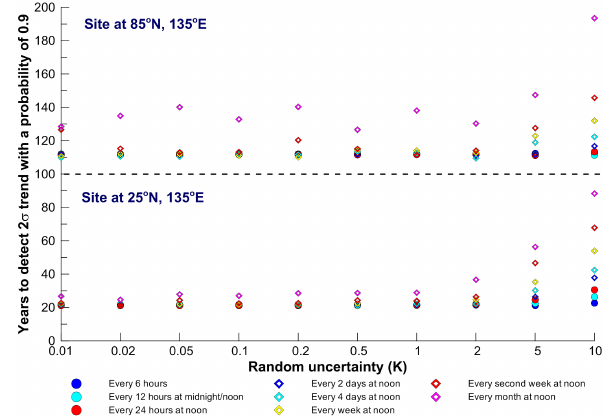
Figure 7. The time to detect projected 21st century temperature trends at 30hPa at two sites for different sampling regimens that include a variety of measurement frequencies and measurement un- certainties. Trends were calculated using a standard least-squares regression model taking monthly means as input, calculated from individual measurements at the stated frequency and measurement uncertainty (indicated by the coloured circles and